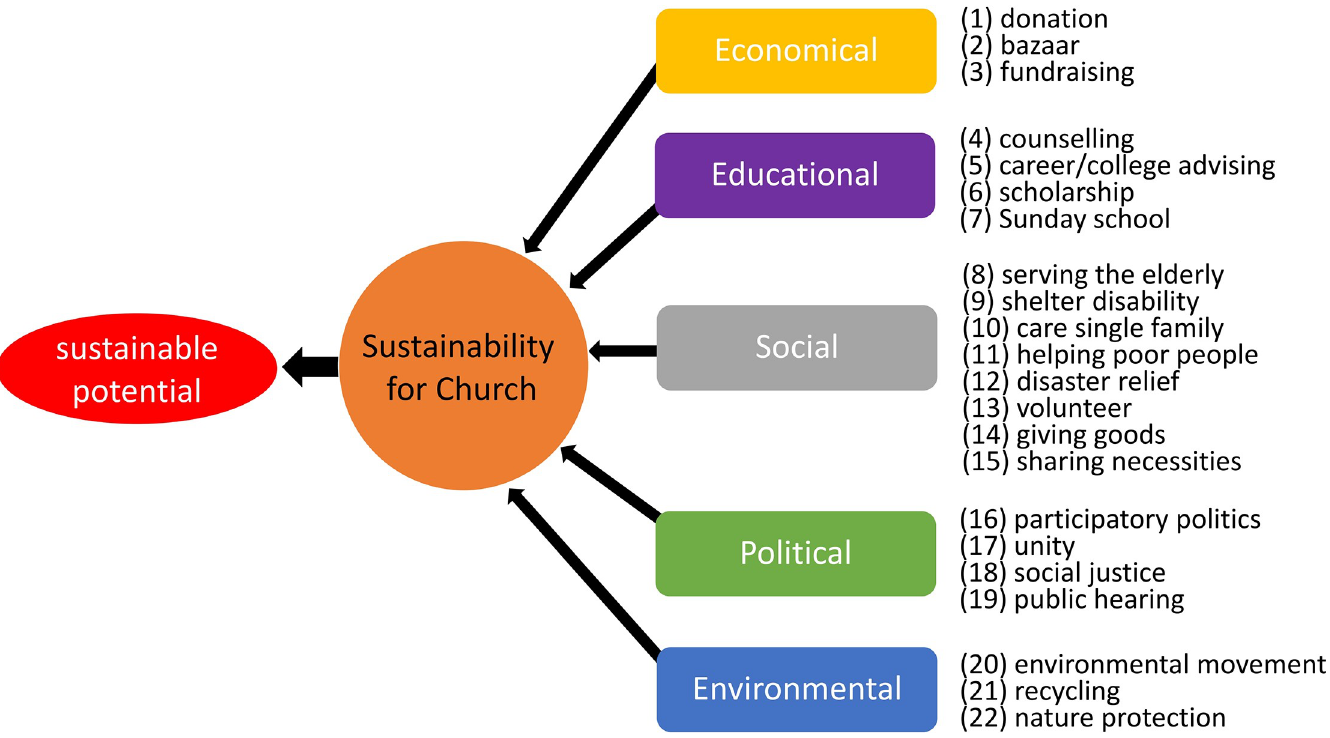
Fig 6. Schematic for obtaining the sustainable potential from church-related sustainability indicators (S6